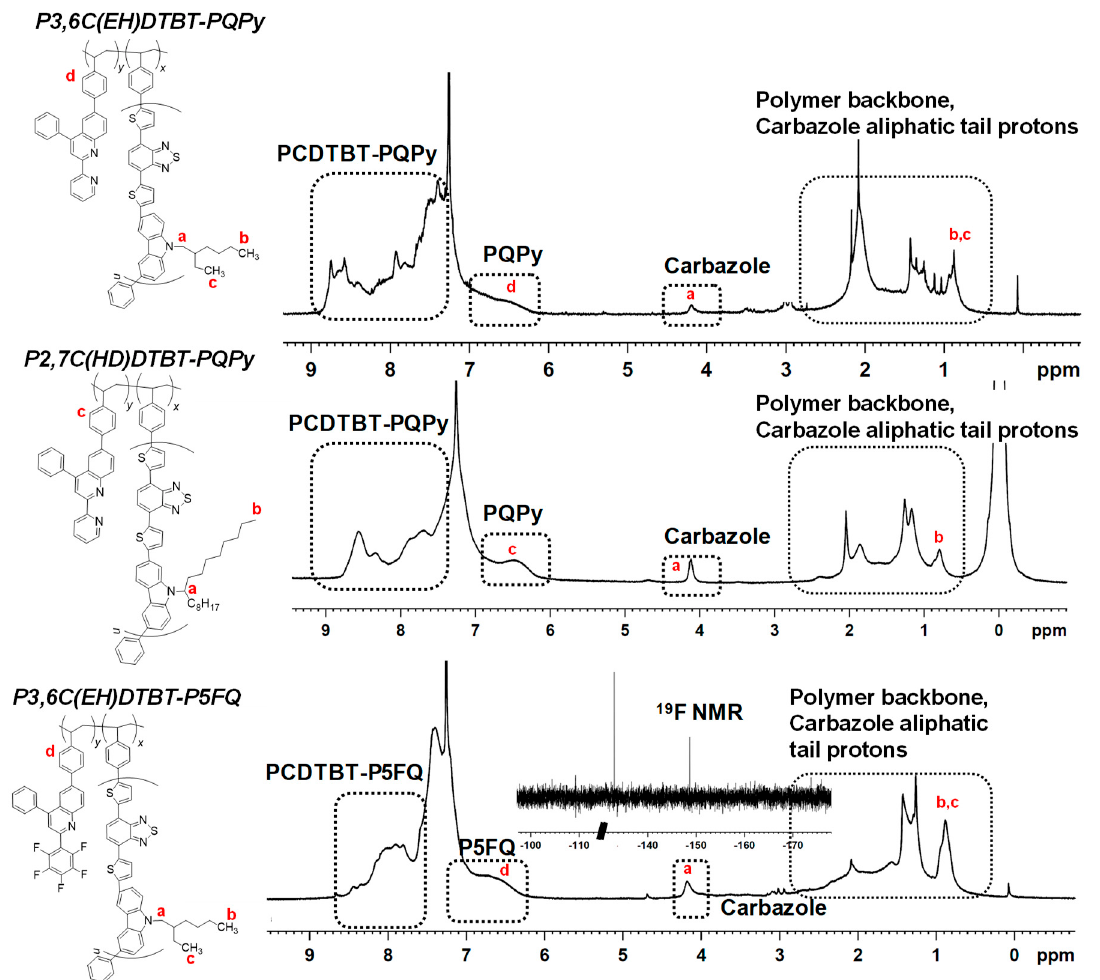
Figure 3. 1 H NMR spectra of the PCDTBT-Quinoline copolymers in CDCl 3.